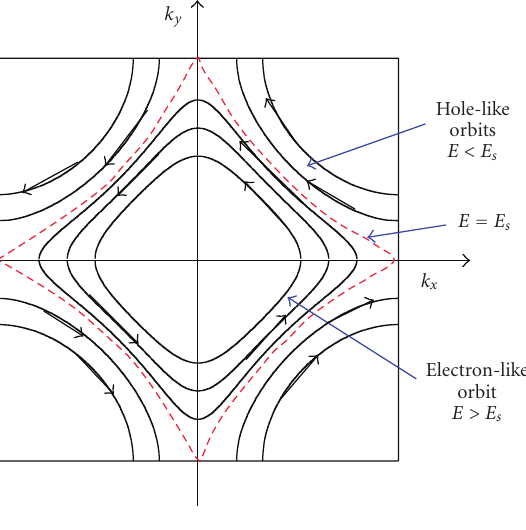
Figure 1: Constant energy surfaces.